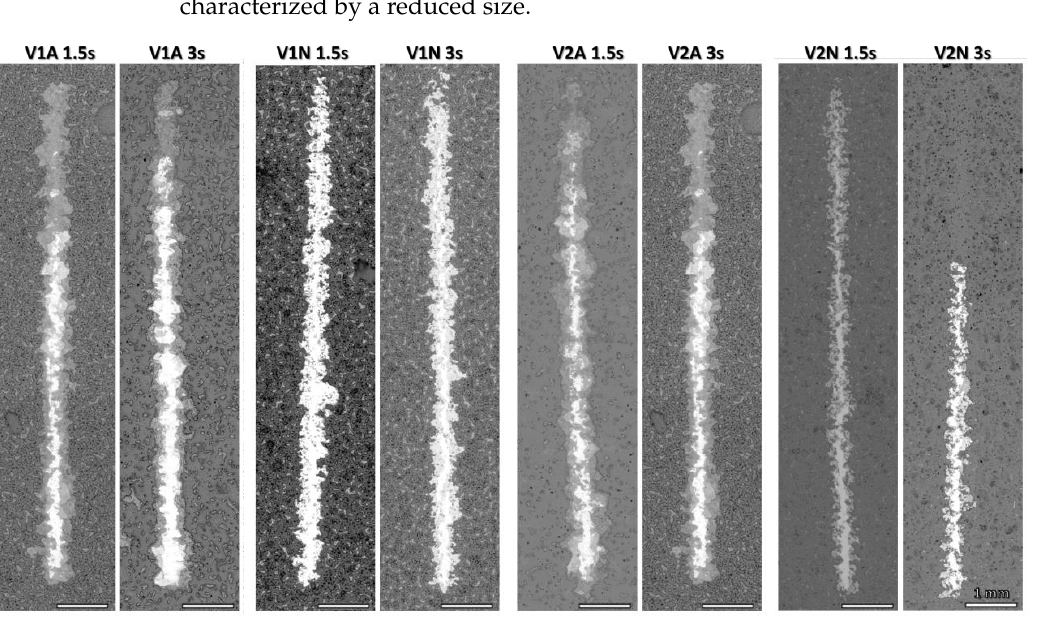
Figure 9. Scratch lines of the coatings deposited for 1.5 s and 3 s.